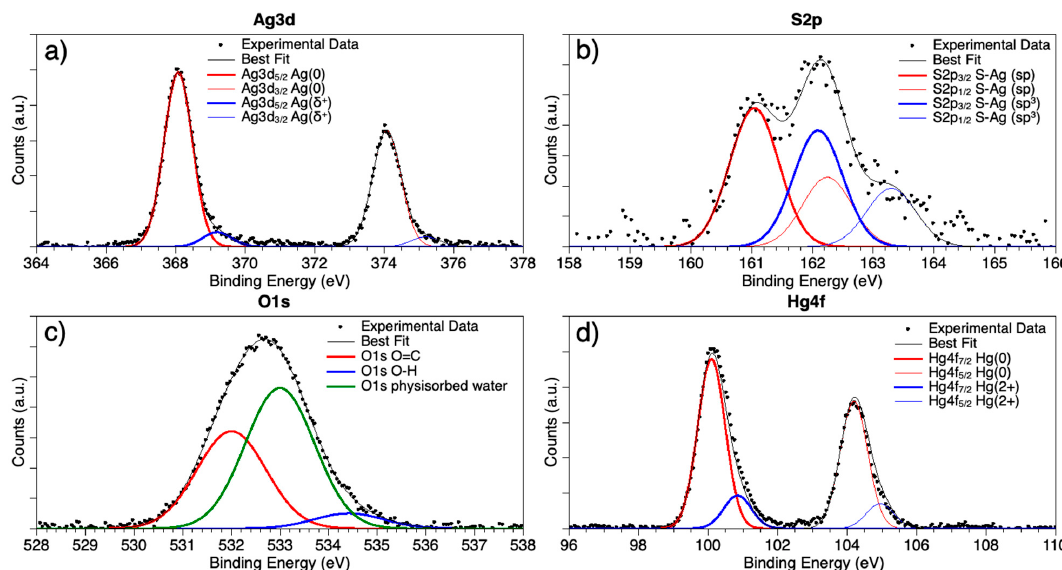
Figure 4. SR-XPS spectra collected on AgNPs-Hg 2+ aggregates at ( a ) Ag3d; ( b ) S2p; ( c ) O1s and ( d ) Hg4f core levels.